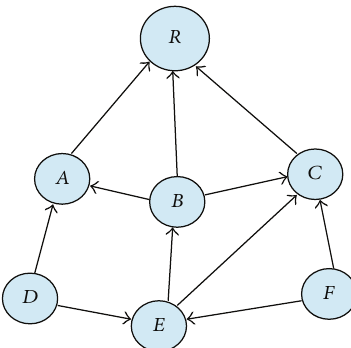
Figure 1: An example DODAG with the root at node 𝑅